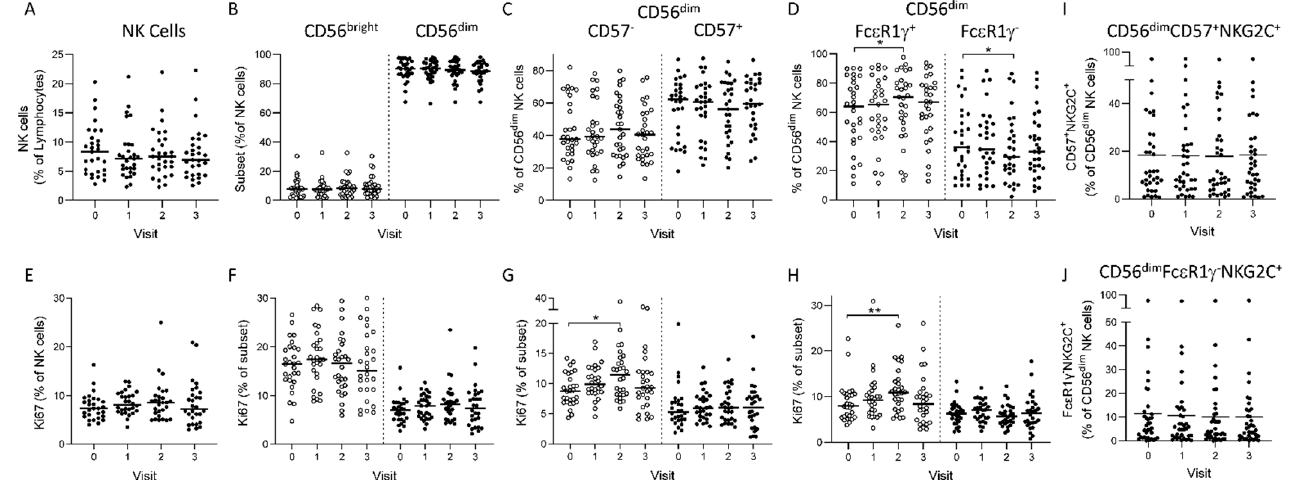
Figure 1. Ex vivo analysis of NK cell subsets and activation markers. Frequencies of NK cells and subsets at Visit zero (baseline), Visit one (post-vaccine dose one), Visit two (21 days post vaccine dose two) and Visit three (180 days post-vaccine dose two) ( A ) NK cells ( B ) CD56 bright and CD56 dim